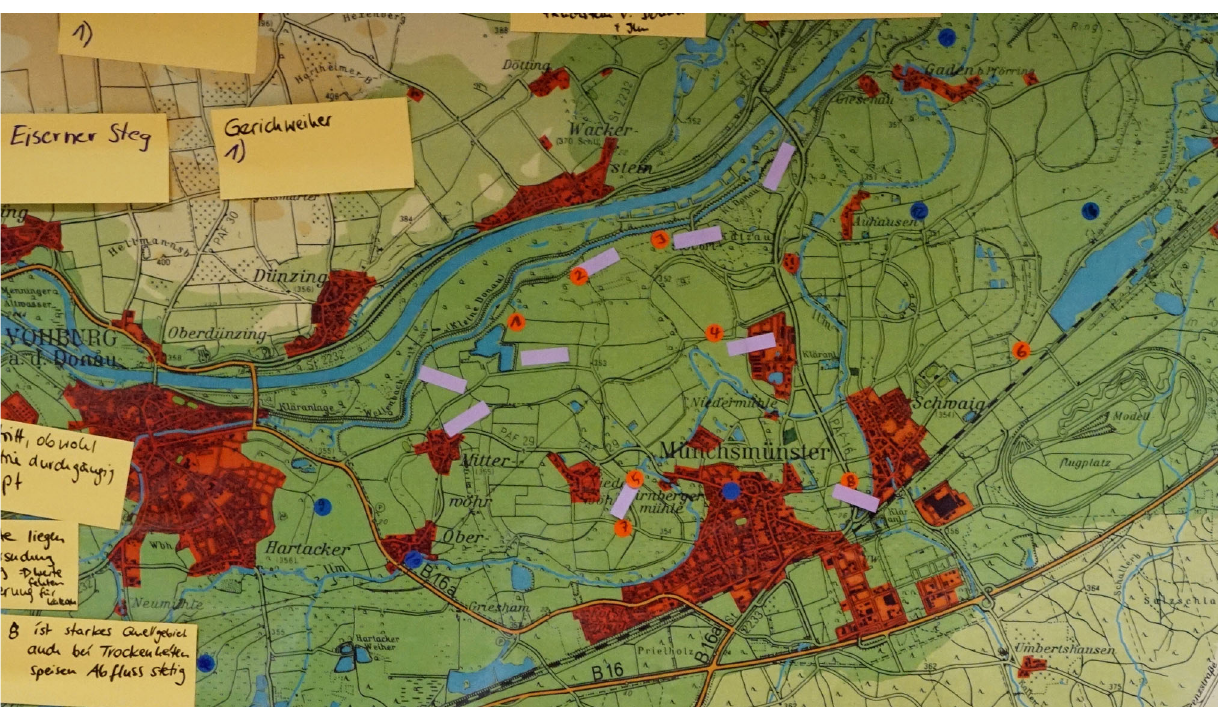
Fig. 5 Wet areas (red dots and pink stripes) in the Mu¨nchsmu¨nster area during the Danube flood event in June 2013, as marked by the round table participants on 7 March 2017. Red areas are buildings (villages)